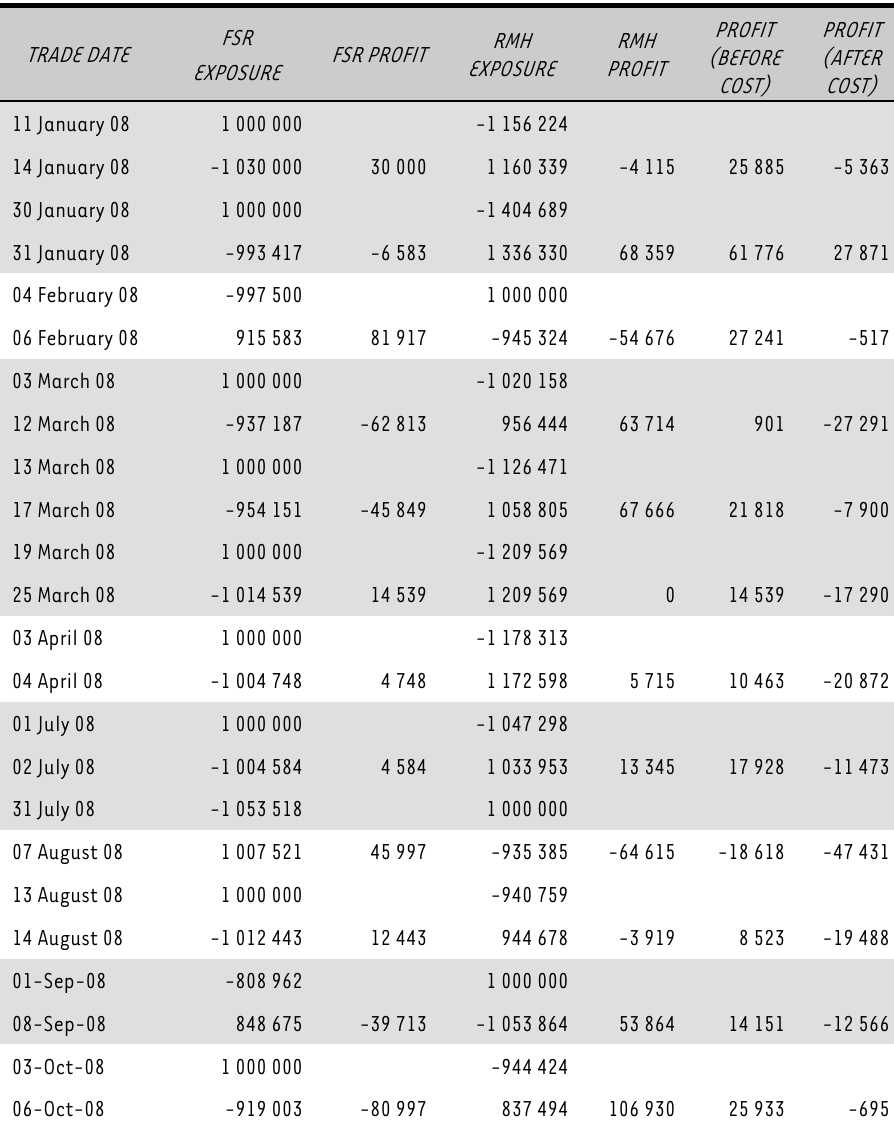
An extract from 2008 onwards of the profits and losses of the FSR-RMH pairs-trading